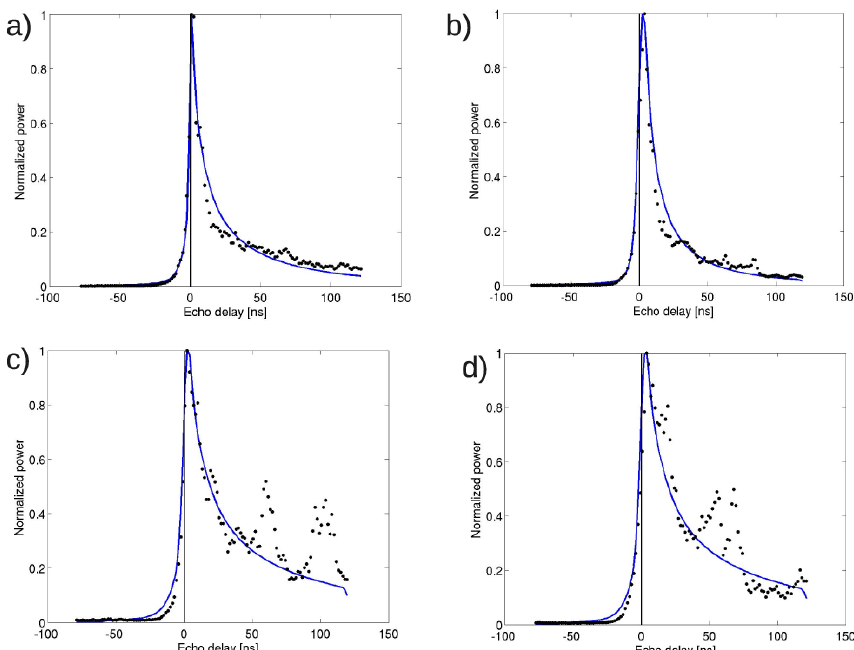
Figure 8. Example CryoSat-2 waveform fits for sea ice floes. The fitted waveform is shown in blue and the CryoSat-2 data are represented by black dots. (a) and (b) are fits of waveforms which demonstrate the good agreement between the observations and the model. (c) and (d) are fits of waveforms containing multiple peaks in the trailing edge due to the presence of strong off-nadir reflections from smooth ice and/or